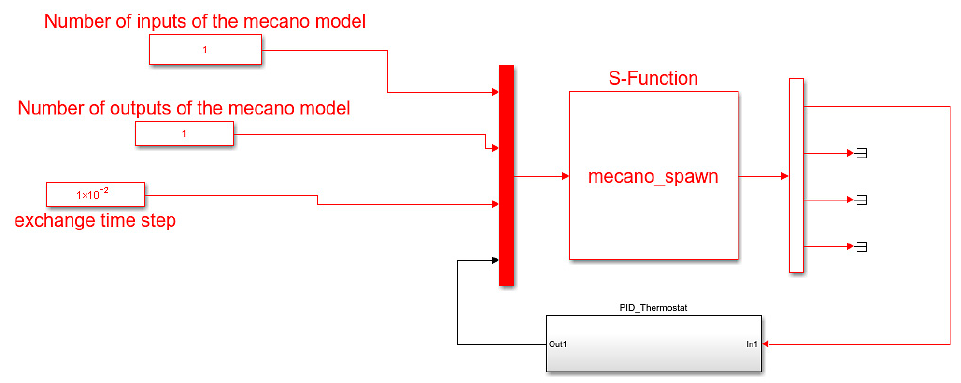
Figure 12. Simulink–SAMCEF co-simulation strategy.